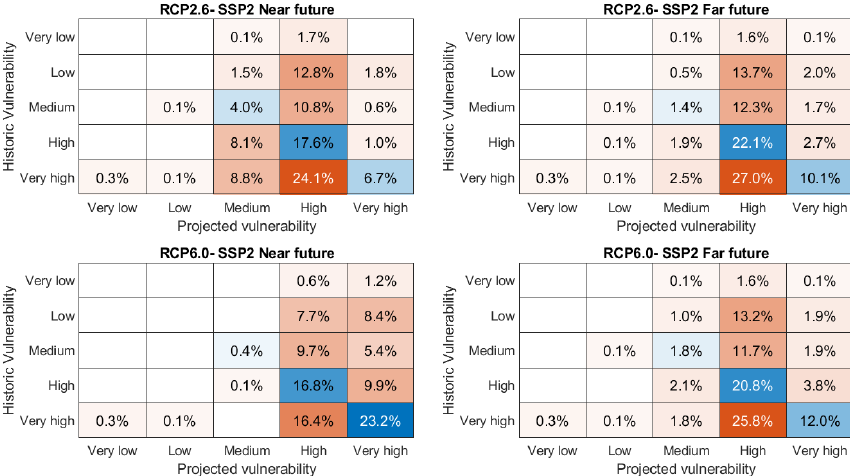
Figure 6. Transition of drought vulnerability from baseline period to projected period. The value in each cell represents the change in percent area of the country from one vulnerability class to another. The red colour shows transition, and blue represents no